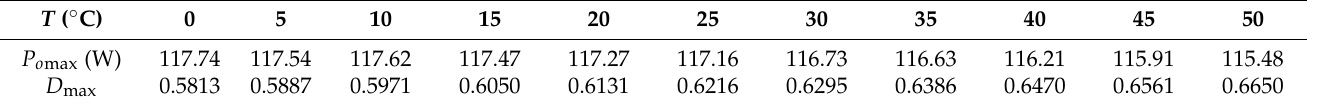
Table 2. MPP values under different temperature, 800 W/m 2 and 1 Ω conditions.